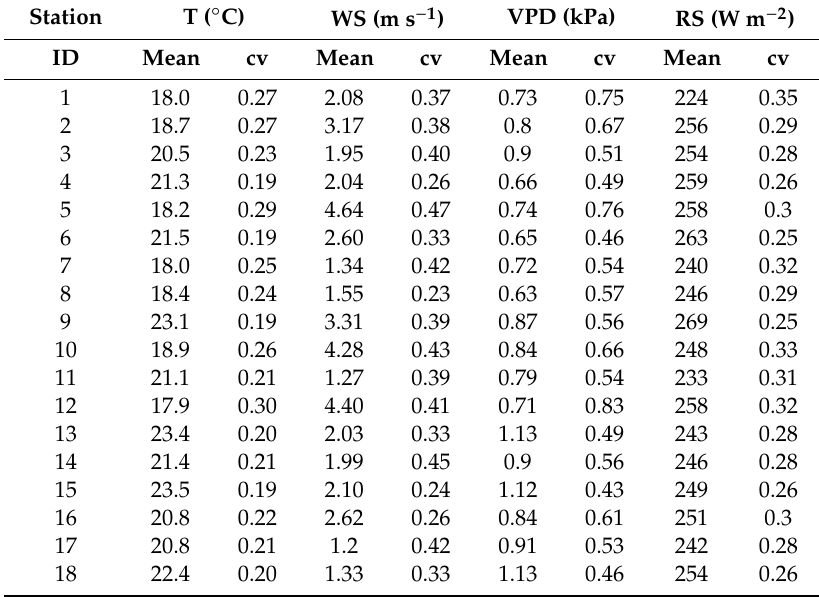
Table 2. Weather data statistics for the irrigation seasons (April–September) of years